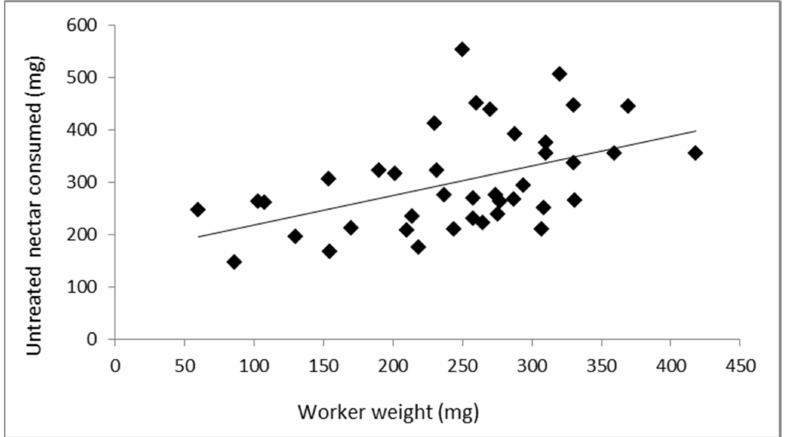
Figure 1. Correlation between the weight of B. terrestris workers fed with untreated artificial nectar and the amount of food